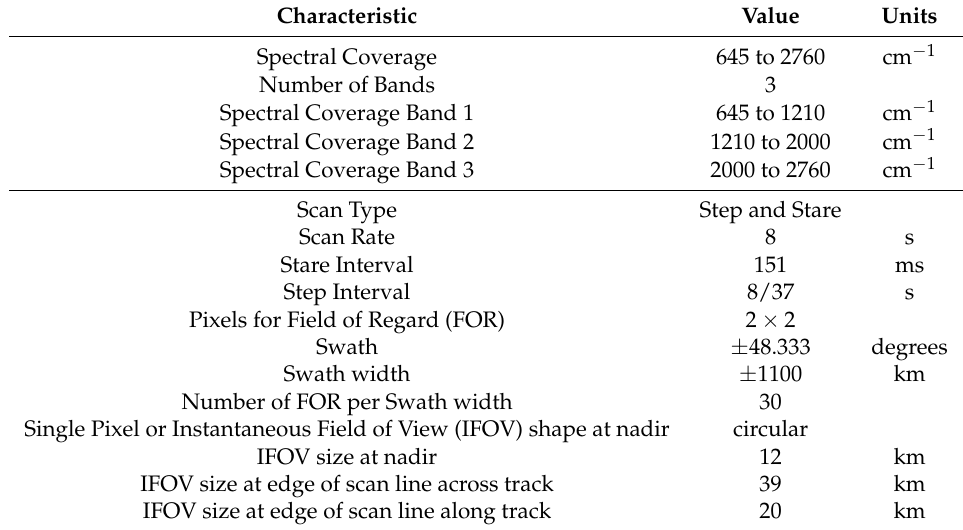
Table 1. IASI instrument and scanning characteristics.